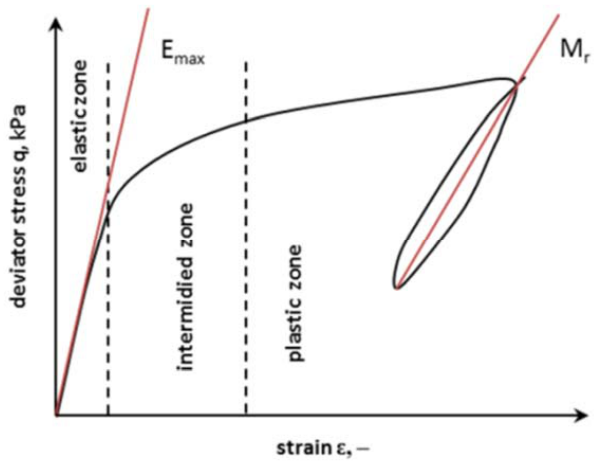
Figure 1. Diagram of differences between the elastic moduli in a small ‐ strain zone and the resilient modulus in a plastic modulus in a plastic zone.